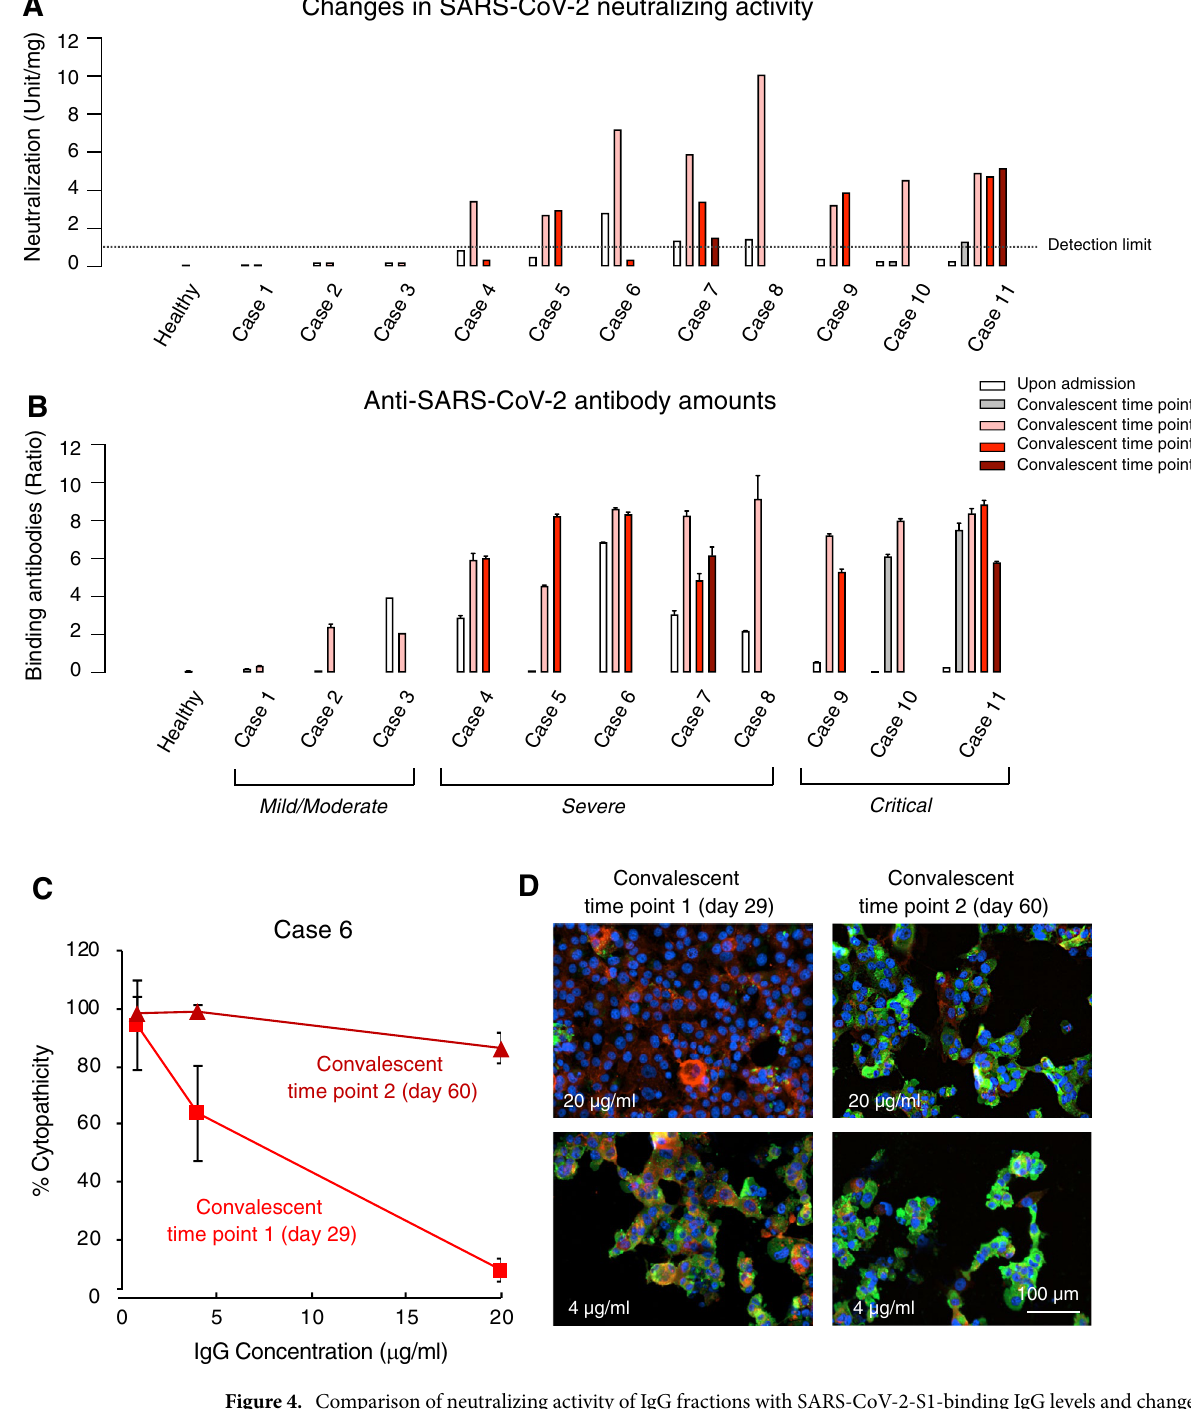
Figure 4. Comparison of neutralizing activity of IgG fractions with SARS-CoV-2-S1-binding IgG levels and changes in neutralizing activity. ( A ) The neutralizing activity of each IgG fraction was normalized and shown as a neutralizing unit. The broken line denotes the detection limit (1 neutralization unit). Regarding convalescence time points, 1 to 4, see “days of sample collections” in Table S1. ( B ) The amounts of SARS-CoV-2-S1-binding IgG were measured using ELISA and shown by the ratios between the extinction of the sample and the calibrator. See Materials and Method section for more details. ( C ) Loss of neutralizing activity of IgG fraction from Case 6 at Convalescence time point 2 (60 days from the onset). Note that the potent neutralization activity of IgG fraction from Case 6 observed at Convalescent time point 1 (29 days from the onset) was lost by Convalescent time point 2. ( D ) Immunocytochemistry of VeroE6 TMPRSS2 cells exposed to SARS-CoV-2 05-2N and cultured in the presence of IgG fraction from Case 6. Note that while the cells were virtually completely protected by IgG fraction (20 µg/ml) at Convalescence time point 1, such activity was significantly reduced and virtually all the cells were infected and stained in green. Cellular actin filaments, SARS-CoV-2 05-2N antigens, and cell nuclei stained in red, green, and blue, respectively. Graphs were generated using GraphPad Prism software version